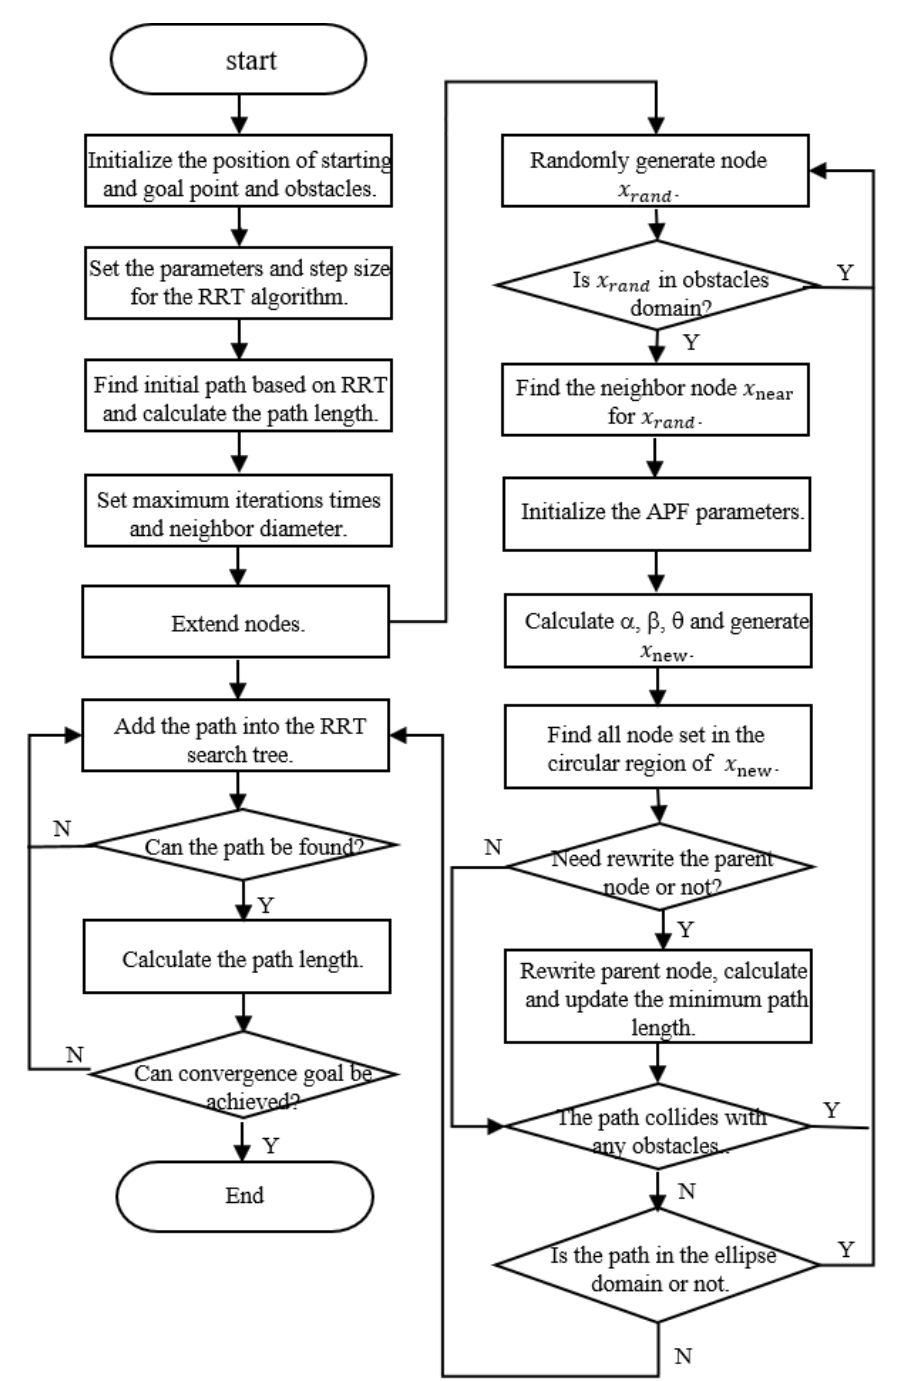
Figure 3. The flow chart of hybrid APF-IRRT* algorithm.